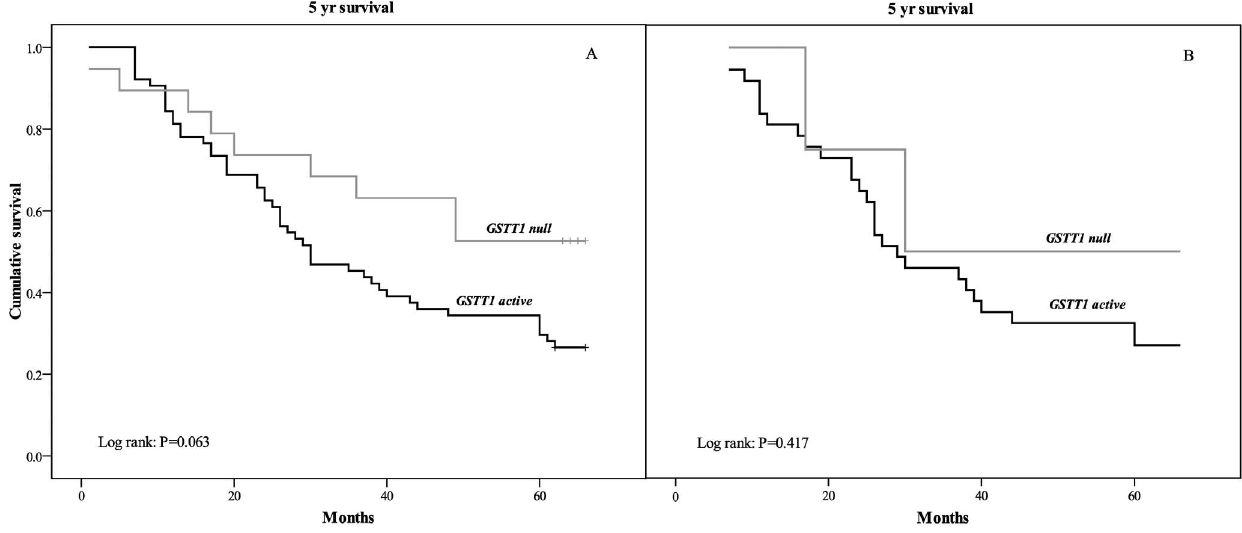
Figure 1. Survival analysis Kaplan–Meier curves according to GSTT1 polymorphism for overall mortality (A), as well as mortality of TCC patients on chemotherapy (B).